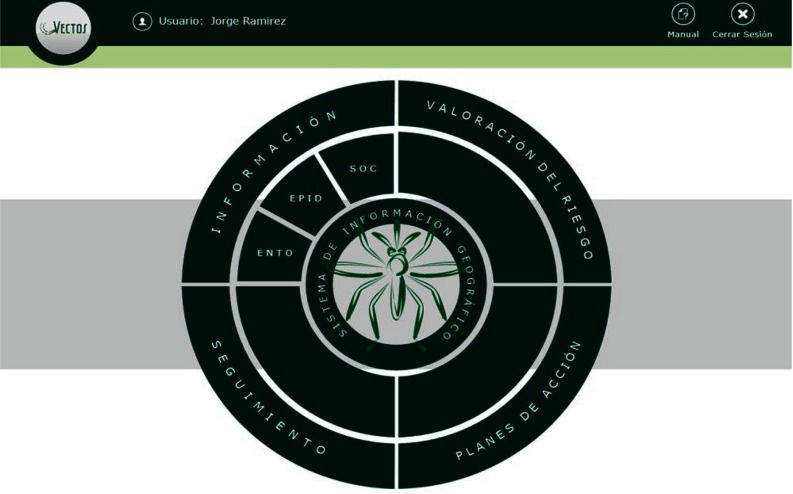
The Initial VECTOS Menu (“Splash Screen”) OptionsFrom top left: Información (Information) leads to data visualization and analysis of entomological (Ento), epidemiological (Epid), or sociological (Soc) data. Valoración del riesgo (Risk assessment) allows the user to create and visualize risk maps. Planes de acción (Action plans) allows the user to organize and schedule field activities. Seguimiento (Follow-up) allows the user to monitor progress on the action plans. In the center: Sistema de información geográfica (Geographic information system) shows the geo-referenced raw data.